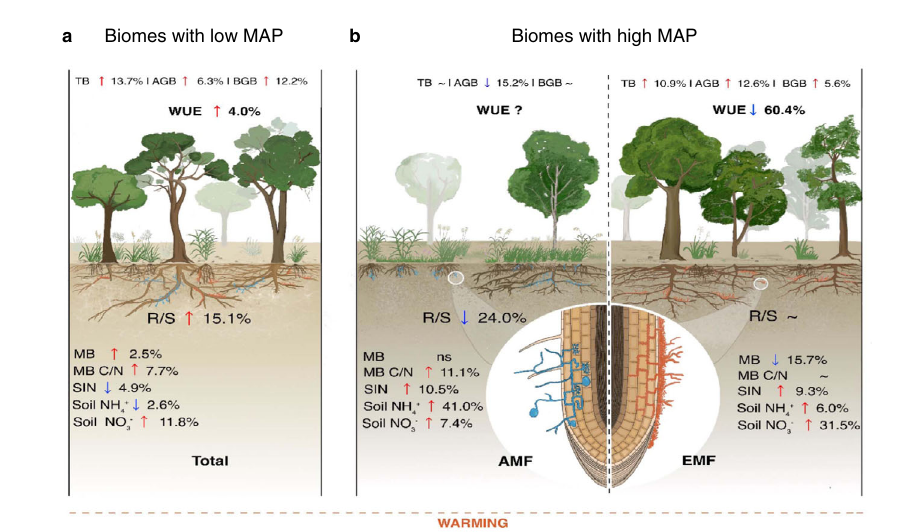
Fig. 7 | Illustration of our main fi nding of warming effects on plant total bio- mass, above- and belowground biomass, and root:shoot ratio. a Biomes with low mean annual precipitation (MAP) irrespective of mycorrhizal association. b Biomes with high MAP and arbuscular mycorrhizal (AMF) or ectomycorrhizal fungi(EMF).TBplanttotalbiomass,AGBabovegroundbiomass,BGBbelowground biomass, MB microbial biomass, MB C/N microbial biomass C N ratio, SIN soil